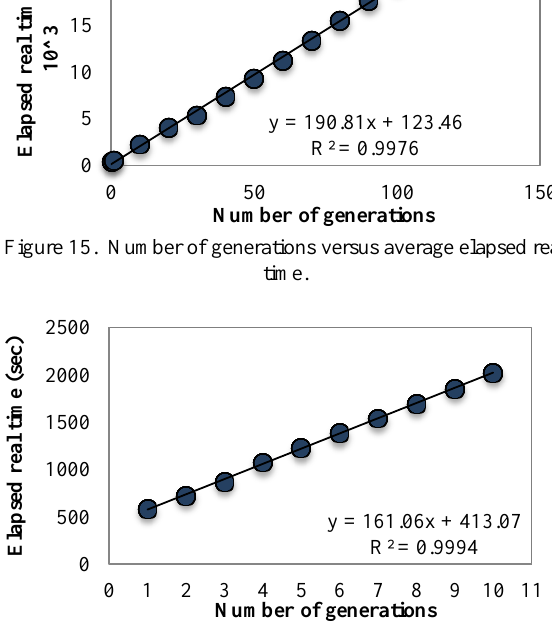
Figure 16. Relationship between the number of generations (1- 10) and average elapsed real